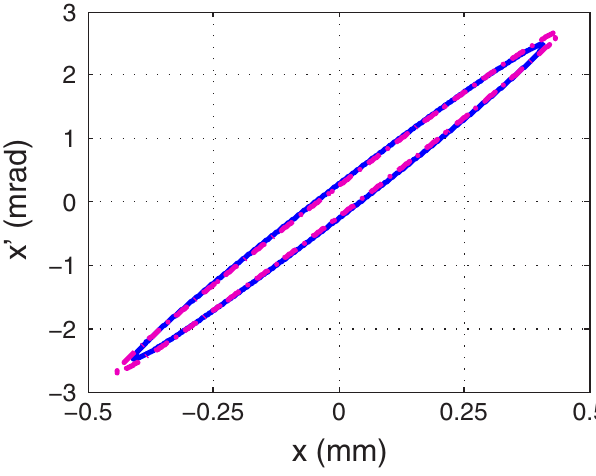
FIG. 8. (Color) Comparison of phase ellipse obtained from the CT technique (blue line) and that from the solenoid scan method (magenta